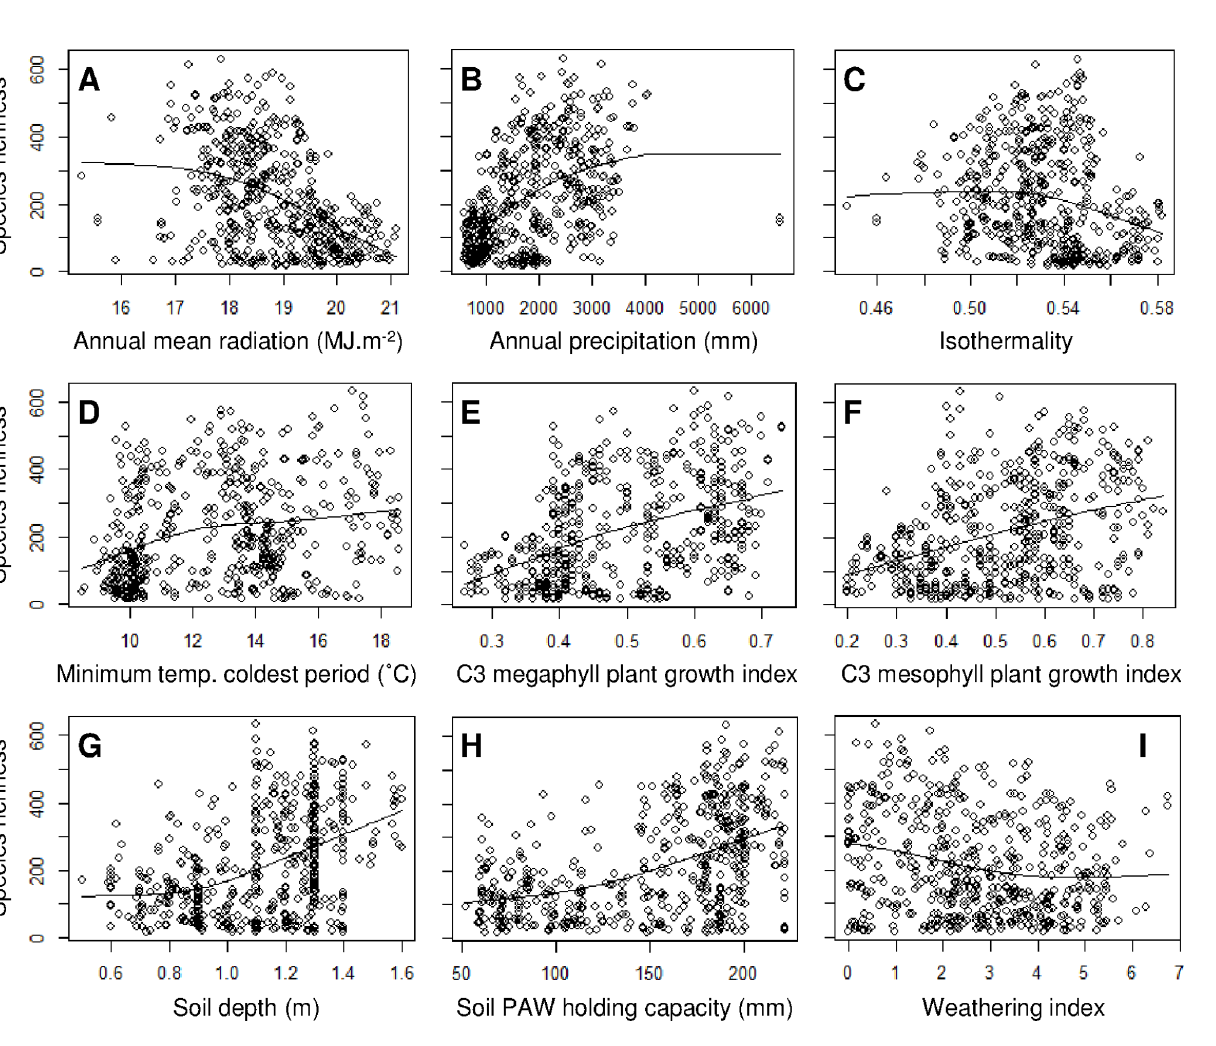
Figure 2. Species richness model response functions. Plant species richness as a function of each of the nine explanatory variables included in the model of plant species richness (( A )–( I )). The line shows the fitted relationship in the model, while observed data for the 527 community survey sites are shown by the open circles (richness scaled to grid cell area). doi:10.1371/journal.pone.0089084.g002 PLOS ONE |